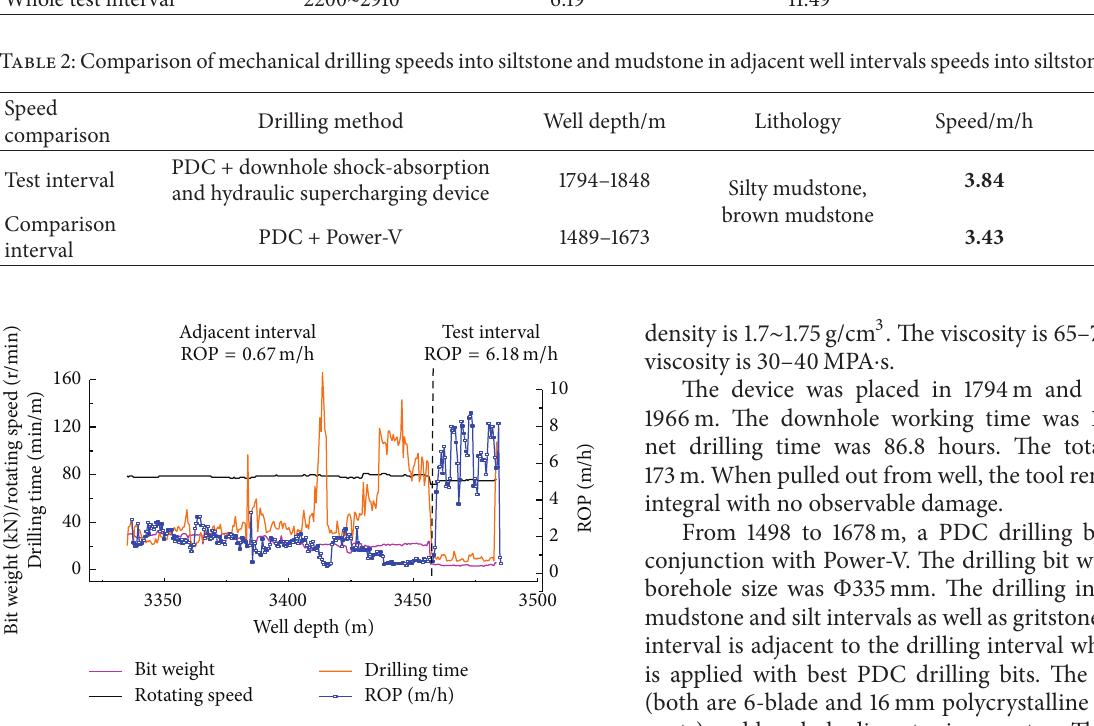
Figure 7: Field test result analysis of ZG10-58